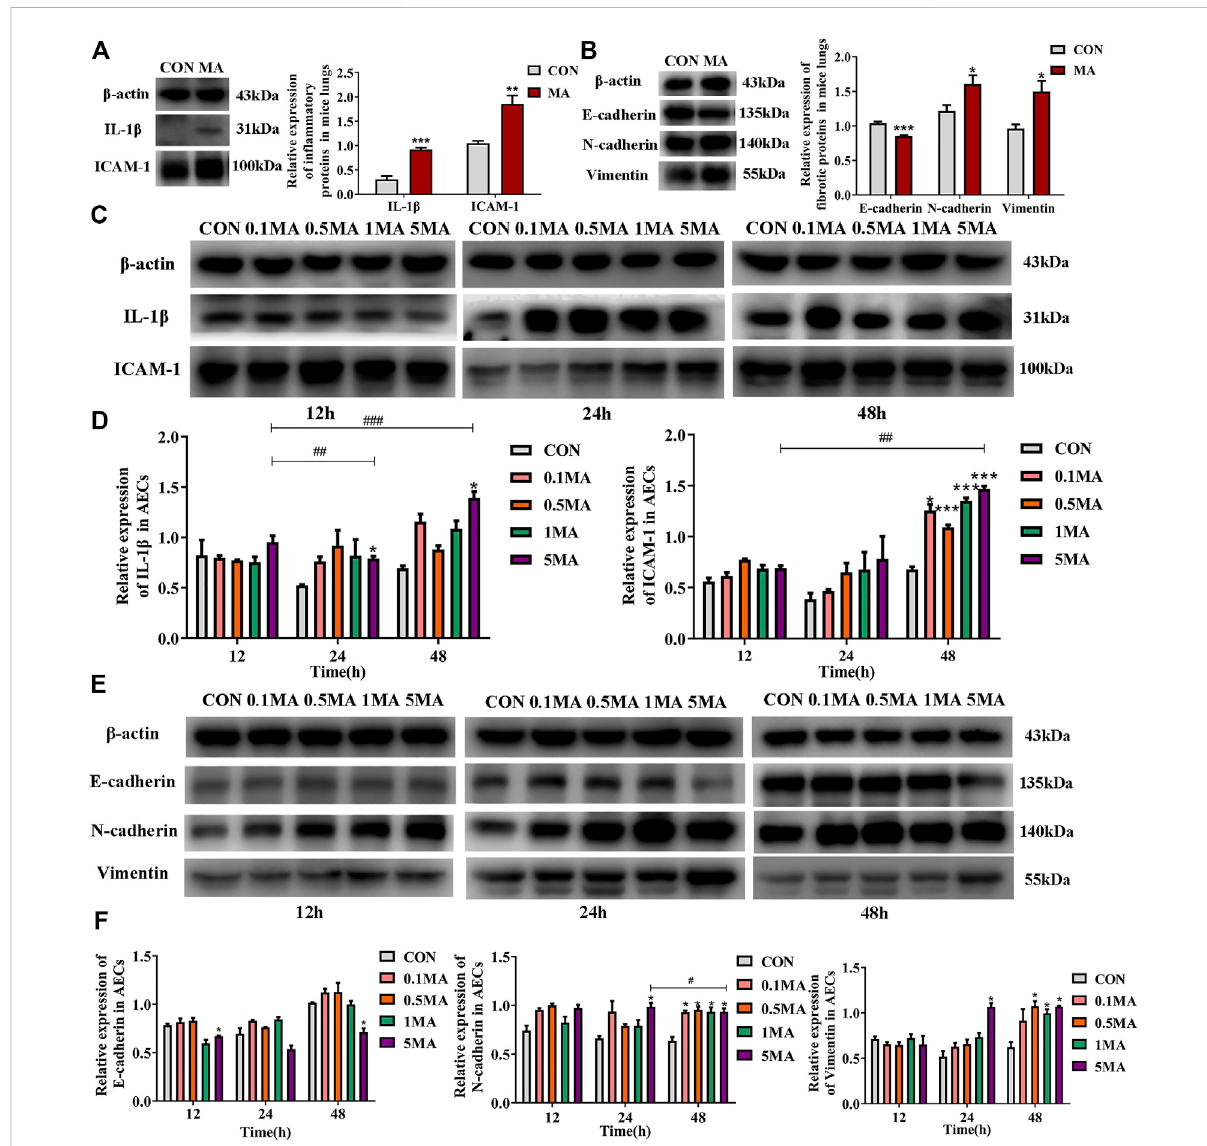
FIGURE 3 In fl ammatory and fi brotic changes induced by MA. (A) The expression of IL-1 β and ICAM-1 in the lungs of the mice in CON and the MA groups. N = 6. (B) The expression of E-cadherin, N-cadherin, and Vimentin in the lungs of the mice in the CON and the MA groups. N = 6. (C) Effects of MA exposure on IL-1 β and ICAM expression in AECs. N = 3. (D) Relative expression of IL-1 β and ICAM-1 in AECs. N = 3. € (E) Effects of MA exposure on E-cadherin,N-cadherin,andVimentinexpressioninAECs.N=3. (F) RelativeexpressionofE-cadherin,N-cadherin,andVimentininAECs.N=3. Data are expressed as mean ± standard deviation, * p < 0.05 vs. CON, ** p < 0.01 vs. CON, *** p < 0.001 vs. CON; ## p < 0.01 vs. 5MA/12h, ### p < 0.001vs.5MA/12h, # p < 0.05vs.5MA/24